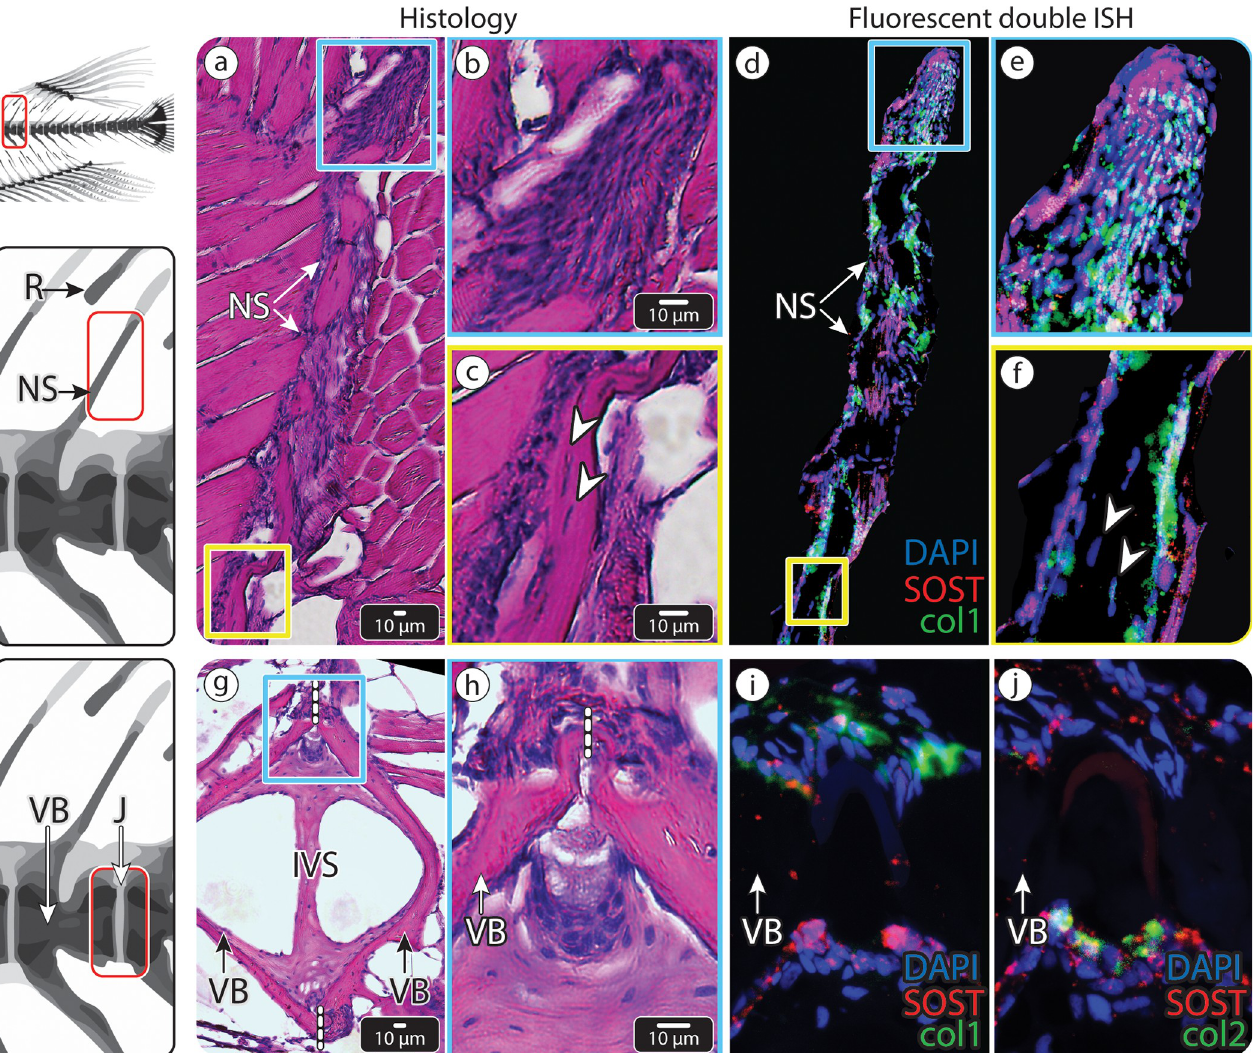
Fig 5. SOST expression in zebrafish vertebra. (a–f) An NS of zebrafish vertebra. (a) HE-stained section. The blue and yellow squares mark distal and proximal regions within the NS, respectively, shown at higher magnification in (b) and (c), respectively. (b) Higher magnification of the tip of the spine. (c) Higher magnification of the spine, showing osteocytes residing inside the bone material (white arrowheads). (d) Double fluorescent ISH showing both Col1a1 (green) and SOST (red) expression in surface cells of the NS, indicating they are SOST -positive osteoblasts. The blue and yellow squares correspond to the regions (b) and (c) in (a) and to (e) and (f). (e) The tip of the spine contains numerous SOST -positive osteoblasts and seems to serve as an active growth region. (f) Osteocytes (white arrowheads) do not appear to express SOST . (g–j) The IVR in the caudal vertebral column of zebrafish, (g) HE-stained sagittal section. Dashed white lines mark the border between one vertebra to another. The blue square marks the intravertebral region shown in (h–j) at higher magnification. (h) Magnification of the IVR, showing the J between 2 adjacent VBs and their distinct cell populations. (i) Double fluorescent ISH ( SOST and Col1a1 ) identifies the upper cell population in (h) as osteoblasts since they express Col1a1 a (green) and shows both the upper and lower cell populations to express SOST . (j) Double fluorescent ISH ( SOST and Col2a1 ) shows the lower population of cells to be chordoblasts, based on their distinctive morphology location and expression of Col2a1 (green). These cells also express SOST (red). Scale bars apply to all images of comparable regions (i.e., b and e; c and f; h, i, and j). Results for individual stains (e.g. DAPI, SOST , col1, col2) are shown in S5 Fig. Col1a1 , collagen type I alpha 1; Col2a1 , collagen type II alpha 1; HE, hematoxylin–eosin; ISH, in situ hybridization; IVR, intervertebral region; IVS, intervertebral space; J, joint; NS, neural spine; R, radial; VB, vertebral bone.